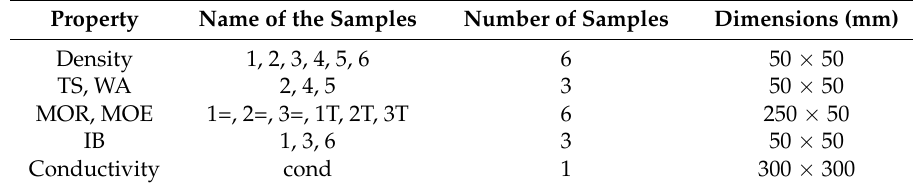
Table 1. Name of the samples and tests conducted.